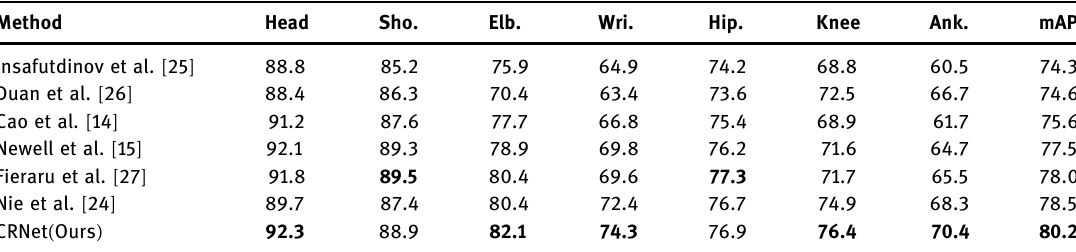
Table 2: Comparison with state - of - the - arts on the MPII test - dev set Method